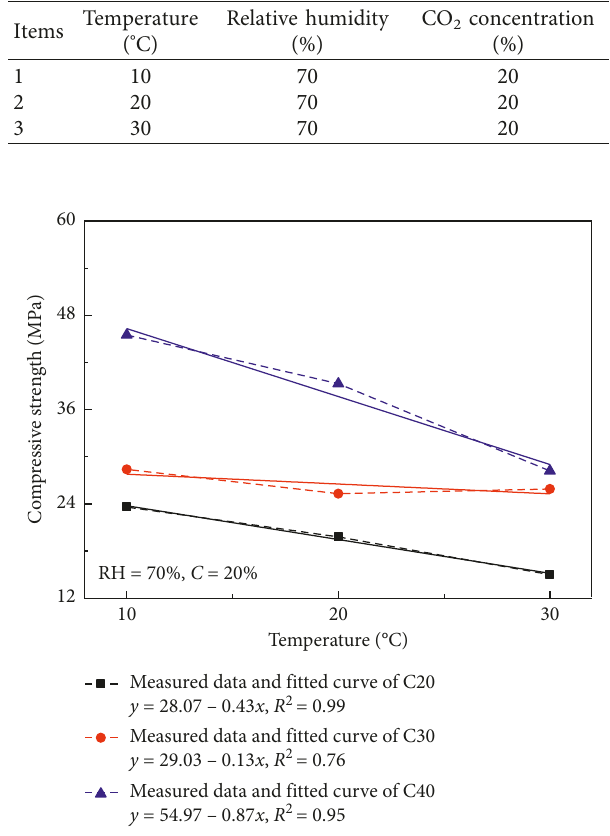
Figure 1: Curves of concrete compressive strength with temperature.